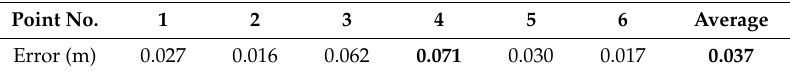
Table 5. Point error in spatial transformation in bad condition.